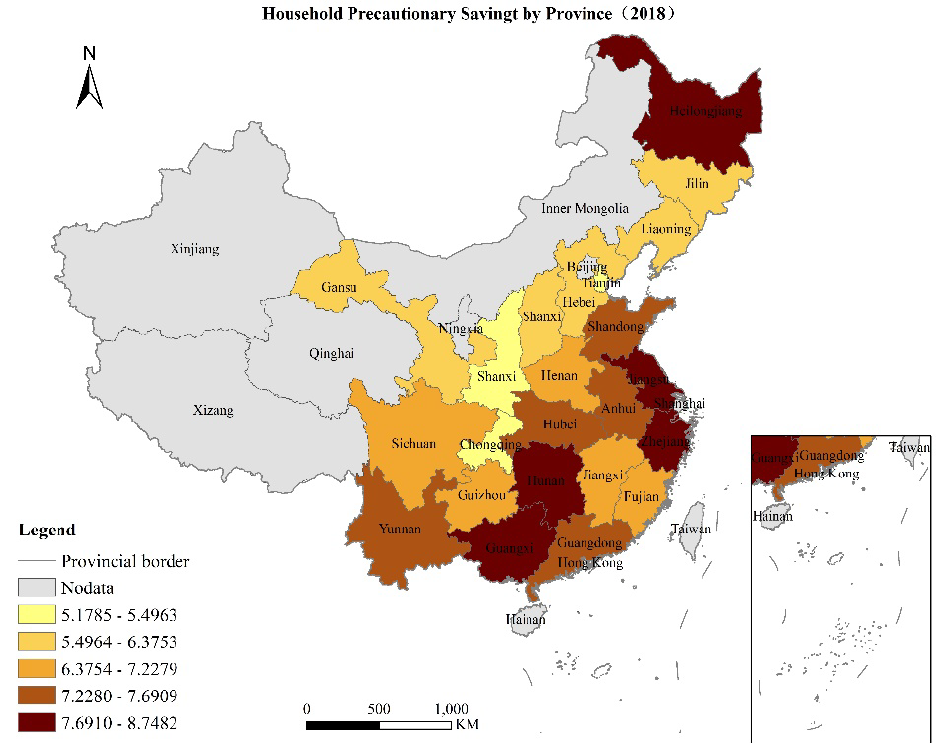
Figure 5. Household precautionary saving by province (2018).